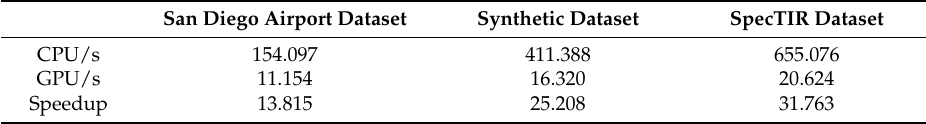
Table 1. Processing Time (In Seconds) for CPU and GPU Implementation of WSSKRX.